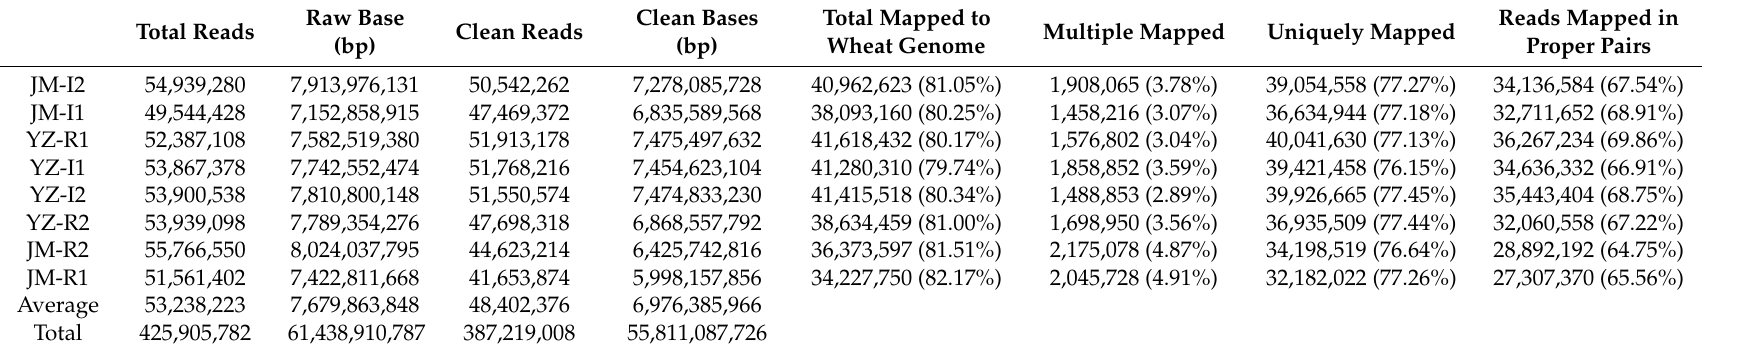
Table 1. Summary of RNA-seq and mapping data.